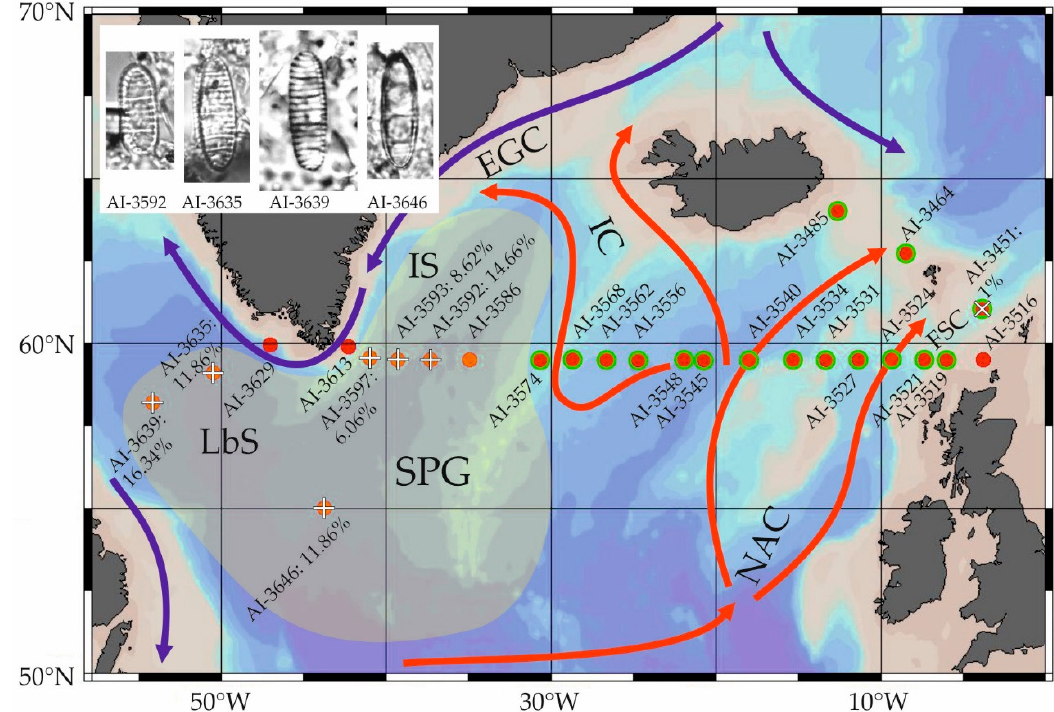
Figure 1. The map of analyzed surface sediment samples (red dots) on the North Atlantic transect at 59.5 ◦ N (Table A1). The name of the station follows the position of the sample. White crosses mark samples with N. seminae ; percentages after the station name show N. seminae abundances. Green-framed red dots mark samples with warm-water subtropical diatoms. Red arrows mark warm surface currents, and blue arrows mark cold surface currents. SPG is Subpolar Gyre, LbS is Labrador Sea, IS is Irminger Sea, NAC is North Atlantic Current, IC is Irminger Current, EGC is East Greenland Current, FSC is Faroe-Shetland Channel. The source of the blank map is Ocean Data View software [13]. The microphotographs of N. seminae valves are presented.